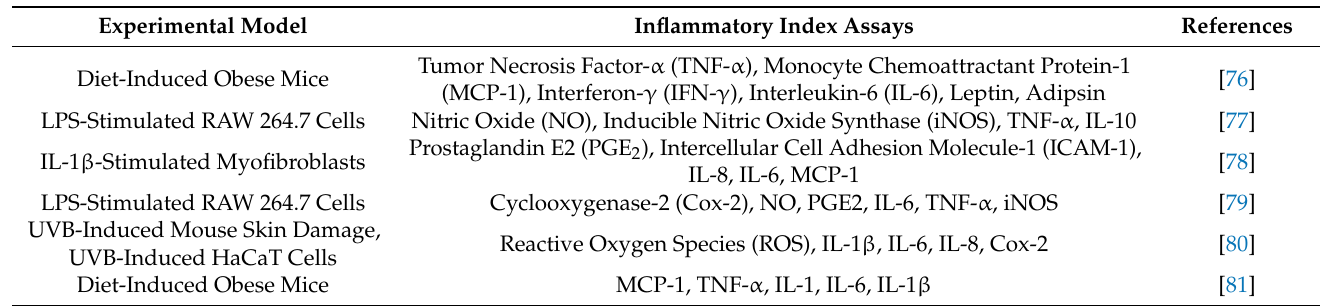
Table 3. Anti-inflammatory effects of